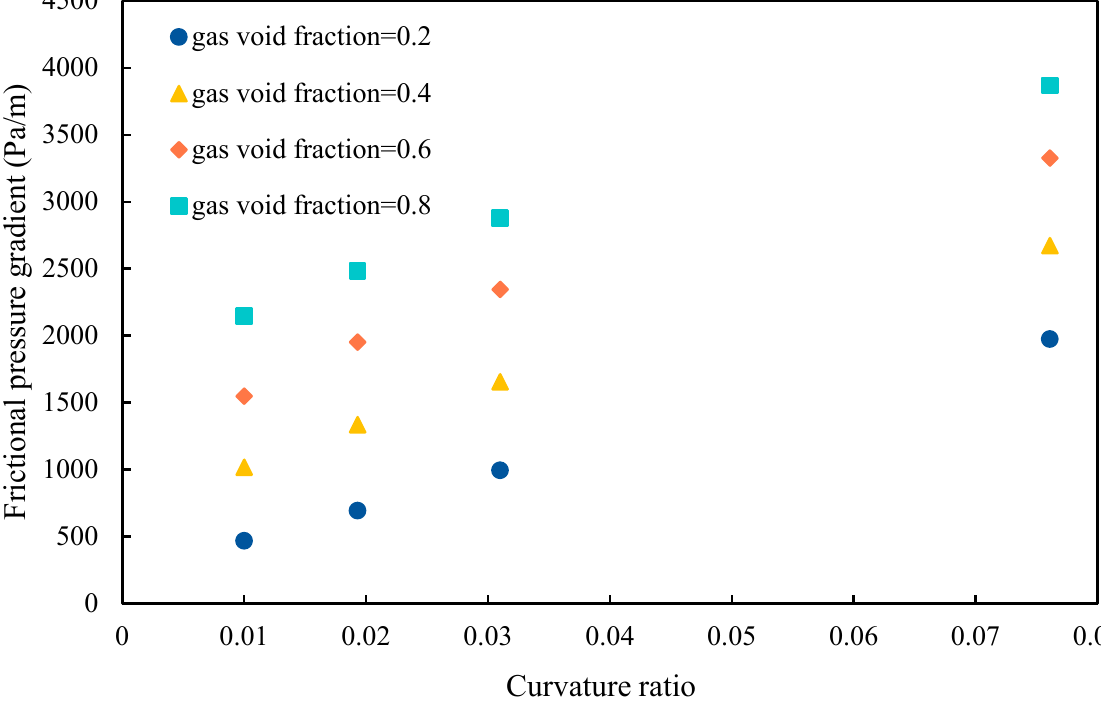
Figure 8. Frictional pressure gradient with curvature ratio at different gas void fractions.